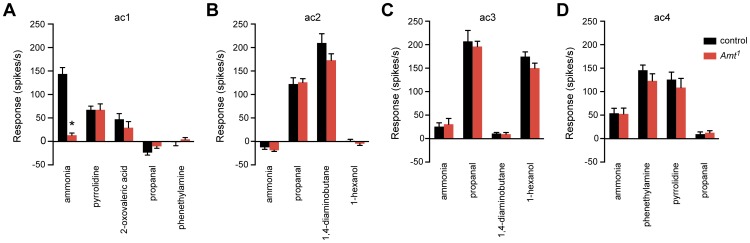
The Amt1 defect is restricted to the ammonia response of ac1 sensilla.(A) Odor responses of ac1 sensilla in Amt1. Ammonia, 2-oxovaleric acid, and pyrrolidine each activate one of the three ORNs in ac1; only the ammonia response was impaired (n = 10–11, p<0.0001). (B–D) Response profiles of other sensillar types appeared normal (n = 8–9 each).